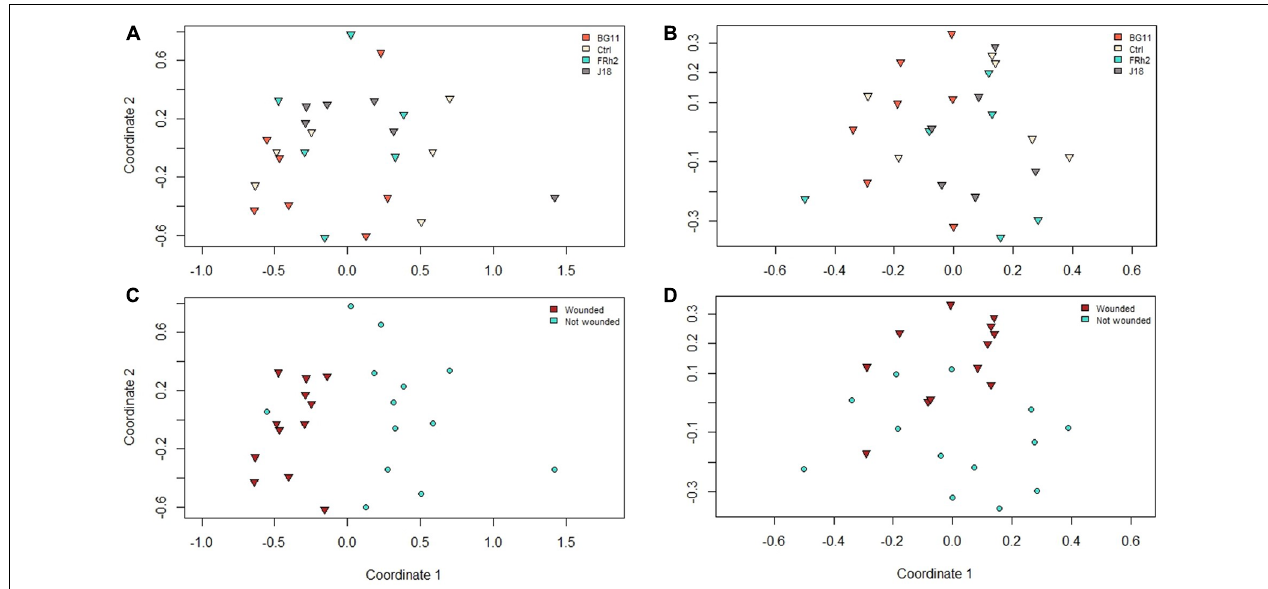
FIGURE 6 | Non-metric multiple dimension scaling (nMDS) plots representing dissimilarities between PCR amplicon profiles from denaturant gradient gel electrophoresis (DGGE) experiments on samples taken from Zea mays (maize) rhizosphere soil DNA, at 30 days after inoculation (DAI), with Beauveria bassiana isolate treatments indicated (see plots legends) for (A) arbuscular mycorrhizal fungi and (B) total fungi, and plant wound treatments indicated for (C) arbuscular mycorrhizal fungi and (D) total fungi.